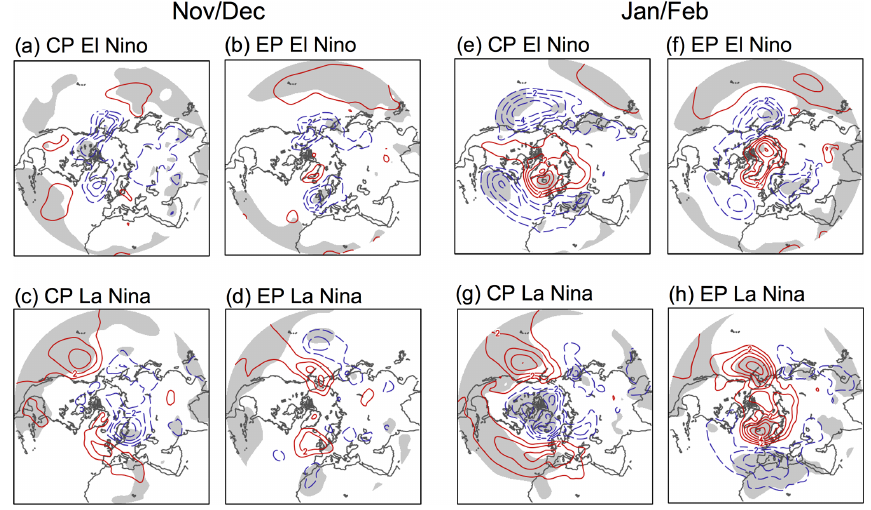
Figure A5. SLP composites for central and eastern Pacific El Niño and La Niña events in the ND or JF means. The contour interval is 1hPa in all panels, with red (blue) contours indicating positive (negative) anomalies. Gray shading indicates a 5% significance level for a two-tailed t test. See Sect. 3.2 for more